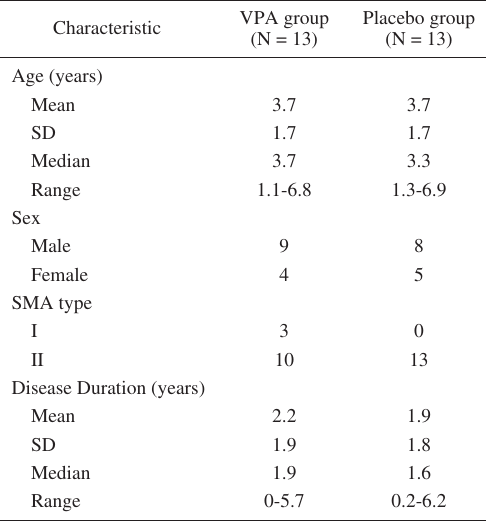
Table 1. Baseline demographic characteristics of 26